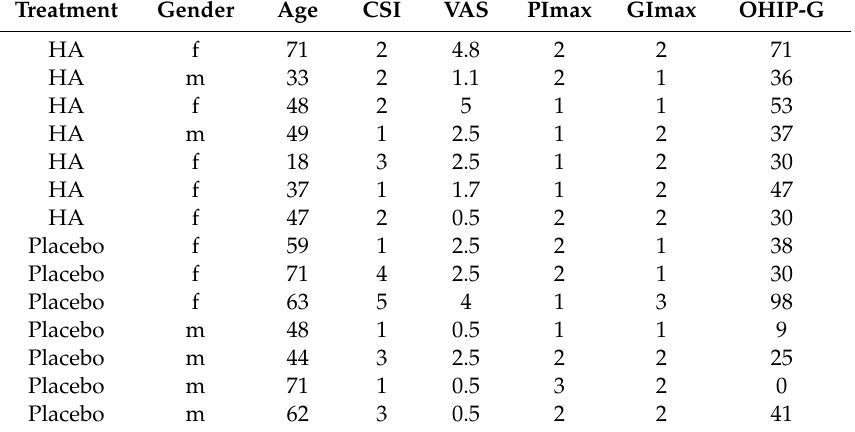
Table 1. Patients included in the study at baseline clinical severity score (CSI), visual analogue scale (VAS), plaque index maximal value (PImax), gingival index highest value (GImax), Oral Health Impact Profile summary score German version